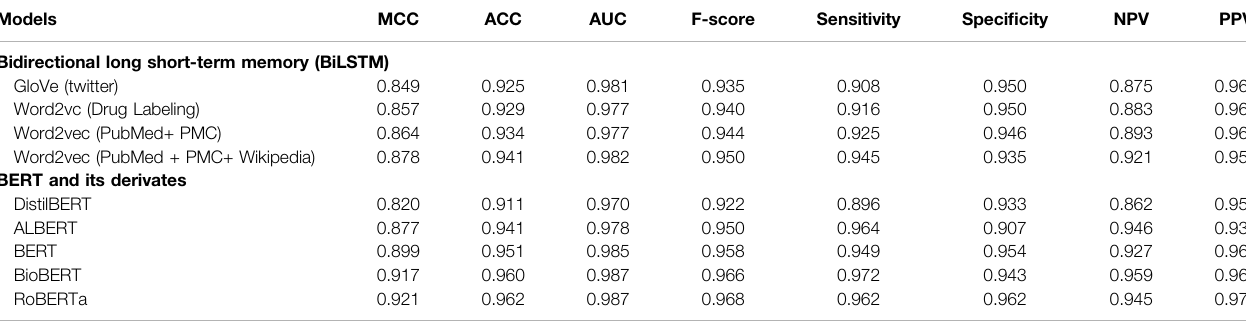
TABLE 1 | Model performances of nine different AI-based models for indication classi fi cation on test set*. Models MCC ACC